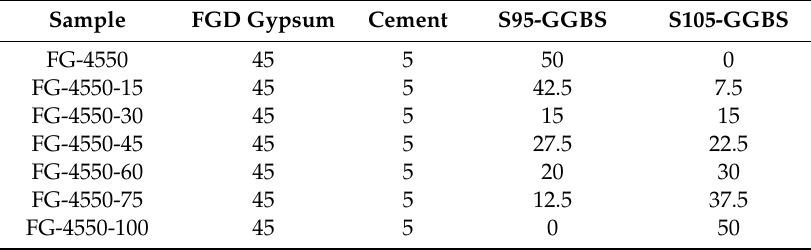
Table 3. Mix proportion of FG-4550 replaced by S105-GGBS